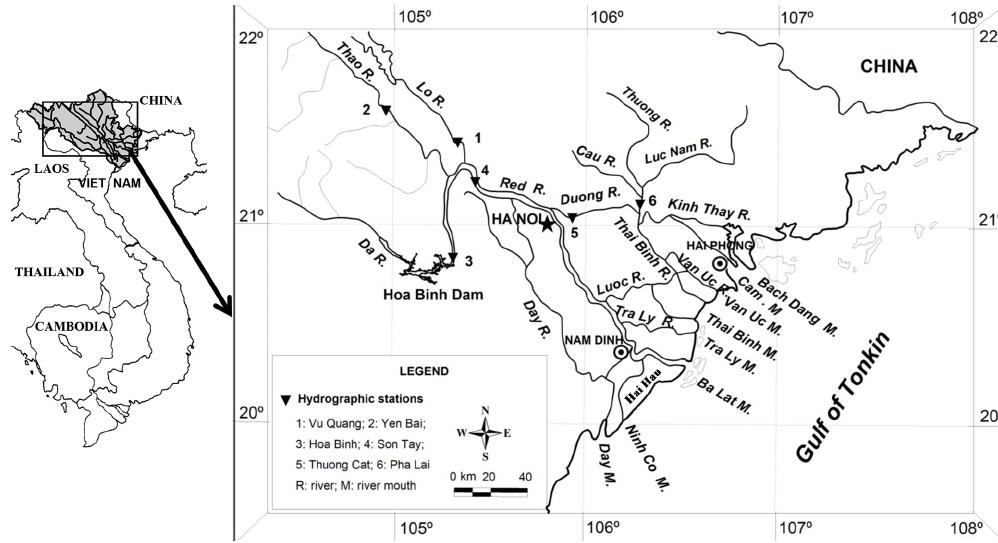
Figure 1. Red River system and the Red River coastal